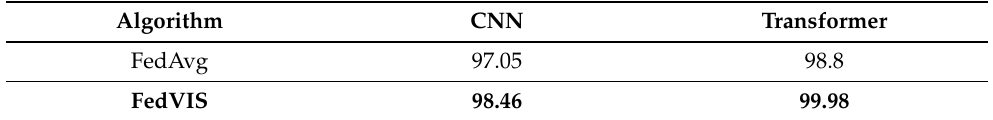
Table 5. The ablation study. The effectiveness of FedVIS was verified by ablation experiments through different steps of separating FedVIS, compared with the classical